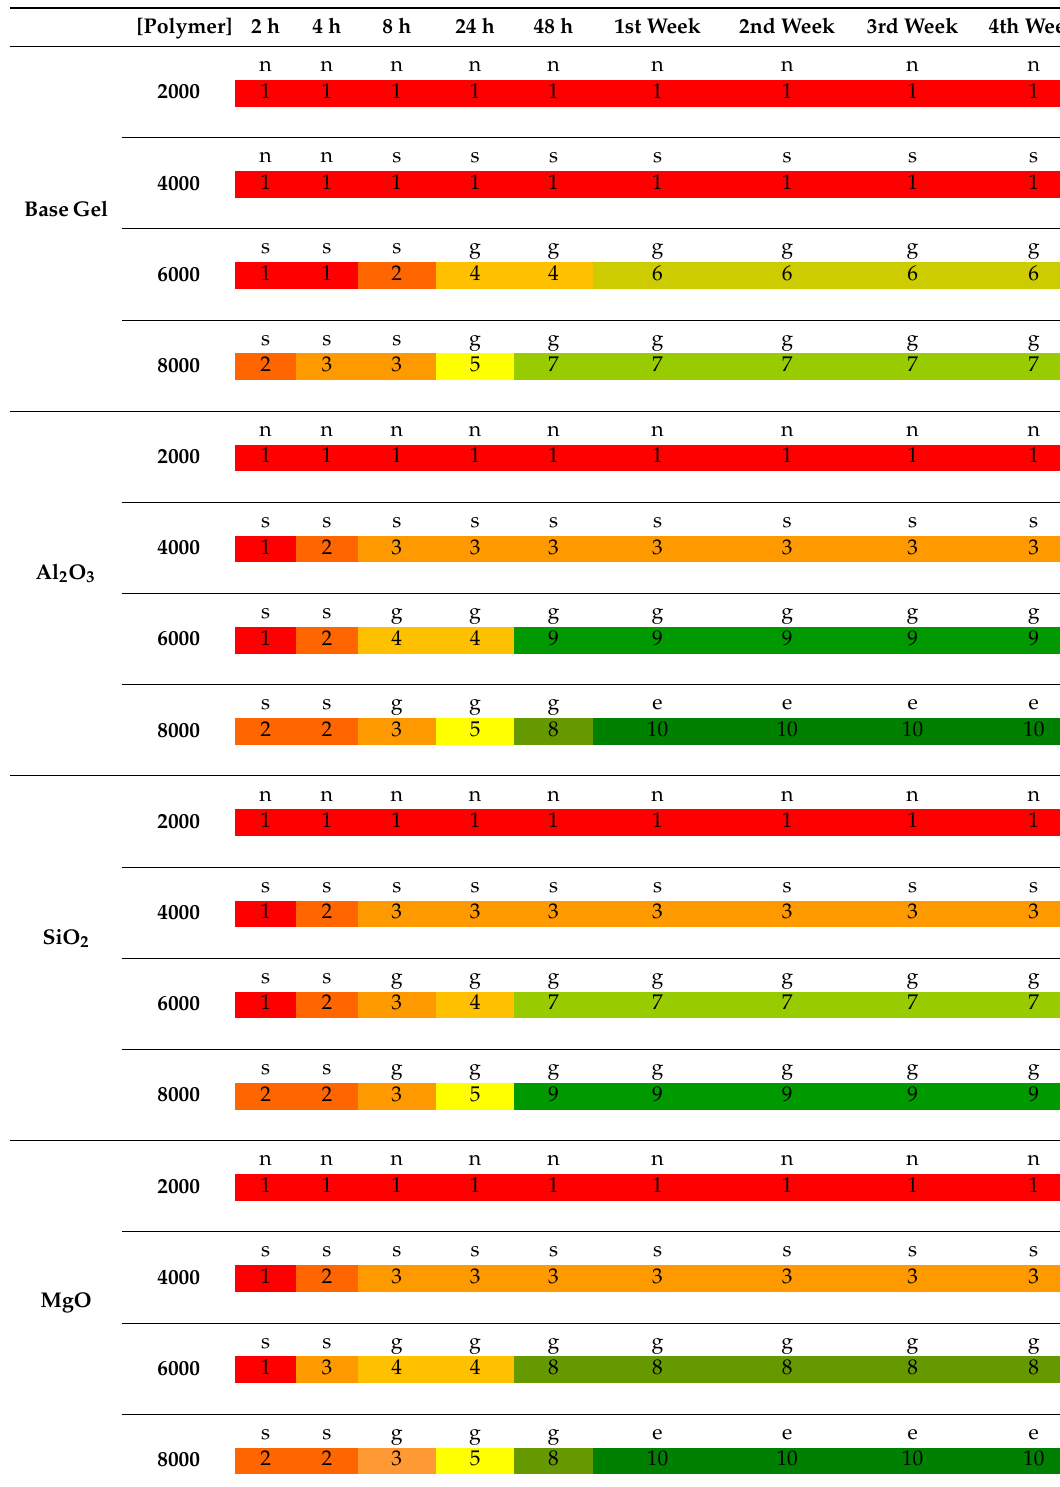
Table 3. Sydansk’s code results for gel systems of acrylamide / sodium acrylate copolymer / chromium (III) Acetate at concentrations between 2000 and 8000 mg · L − 1 in presence and absence of di ff erent nanoparticles at 70 ◦ C 1 as a function of